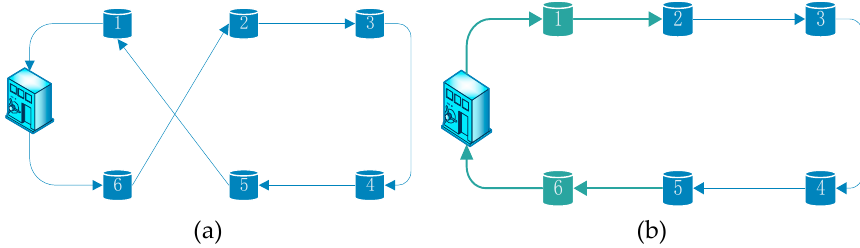
Figure 2. Swap operation. ( a ) Route before swap operation and ( b ) route after swap